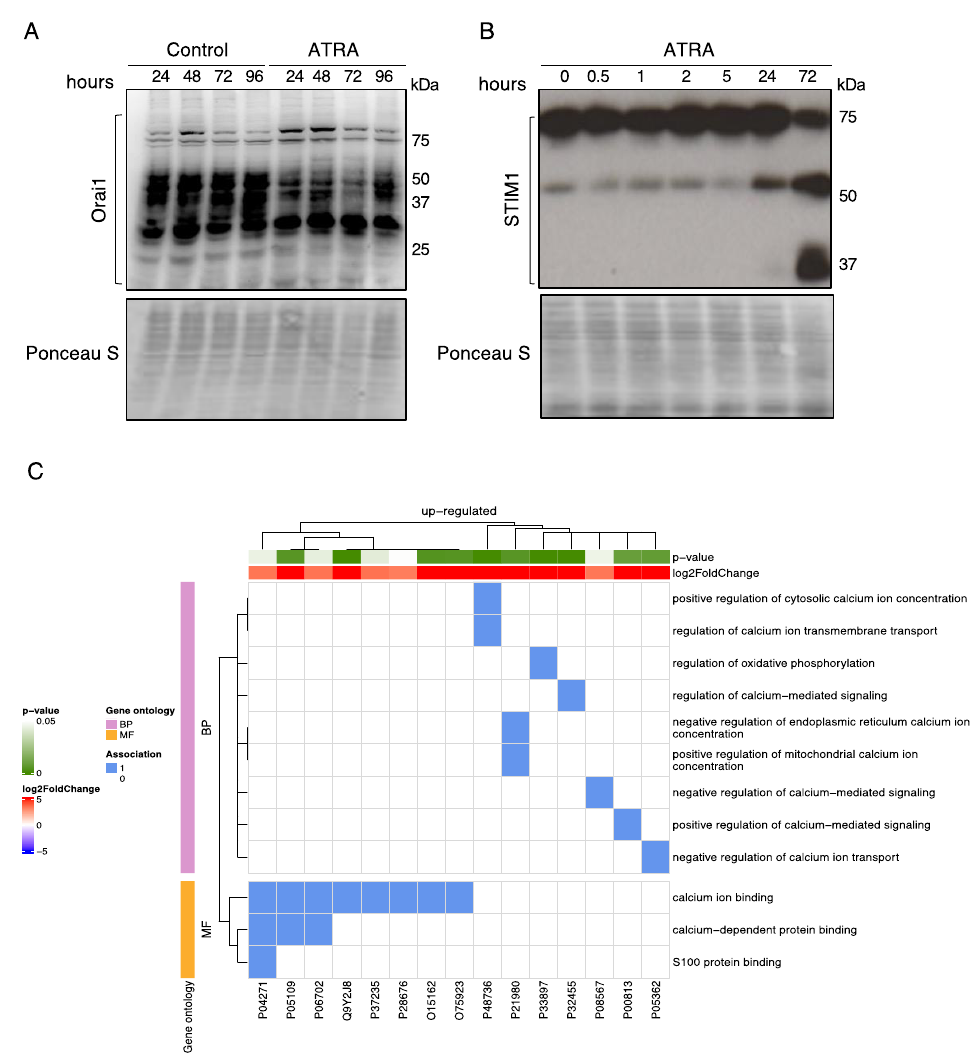
Figure 2. ATRA modulates calcium-regulatory proteins. ( A,B ) NB4 cells were treated with 1 µ M ATRA for the indicated time. Immunoblot analyses of ORAI1 and STIM1 protein expression levels are shown. For each membrane, Ponceau S Red staining was used as protein loading control. Bands corresponding to different forms of ORAI1 and STIM1 are depicted. ( C ) NB4 cells were treated with 1 µ M ATRA for 3 days and then subjected to proteomic analysis. The heat map visualizes the annotation of statistically significant proteins ( p -value < 0.05) identified by proteomics data analysis (columns) by GO terms associated with Ca 2+ signaling (lines; see also Supplementary Data File 3). The blue color represents an existing annotation while the white color represents none.